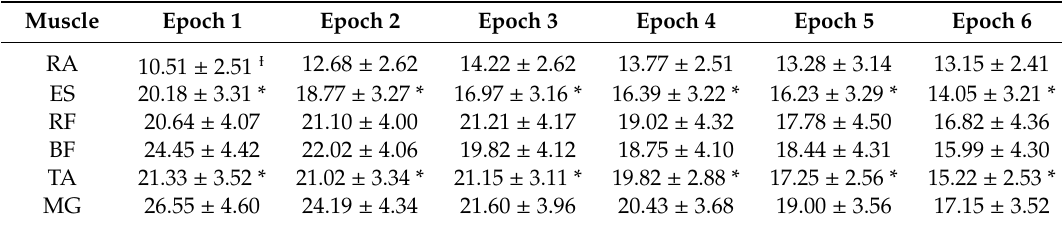
Table 1. Grand mean (mean of the combination of conditions) of normalized EMG integrals (% ʃ EMGmax ) for each epoch.